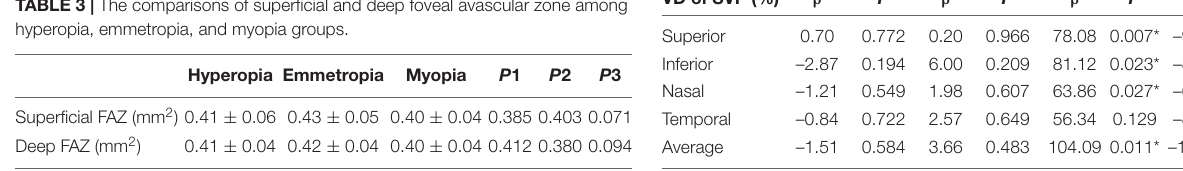
P1: Comparison between hyperopia and emmetropia; P2: Comparison between hyperopia and myopia; P3: Comparison between emmetropia and myopia. GEEs for the intergroup comparisons. Age and sex have been adjusted. FAZ, foveal avascular zone.